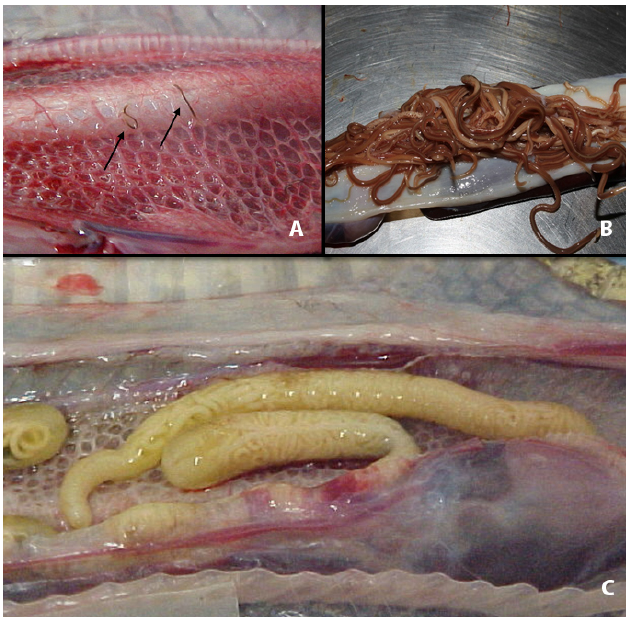
Figure 3. (A) Nematode Rhabdias sp. in the lung of Bothrops jararaca . (B) Ascarids in the upper gastrointestinal tract of Crotalus durissus . (C) Pentastomid parasite in the lung of Bothrops jararaca